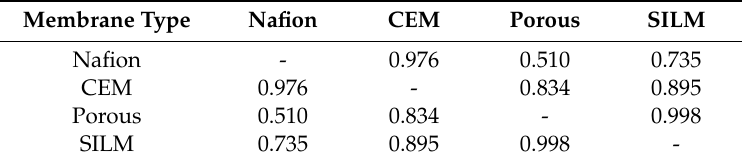
Table 3. The p -values derived from Tukey’s HSD test for the assessment of